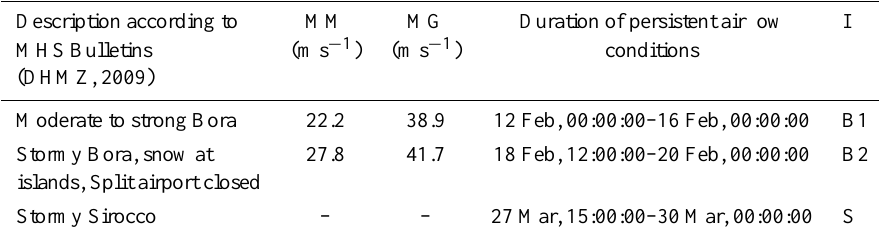
Table 1. List of investigated strong wind episodes. MM and MG correspond to maximum hourly wind speed and maximum wind gust as reported by DHMZ (2009). I is the code of the time interval characterized by persistent airflow, where its persistence is assessed from the modeled wind